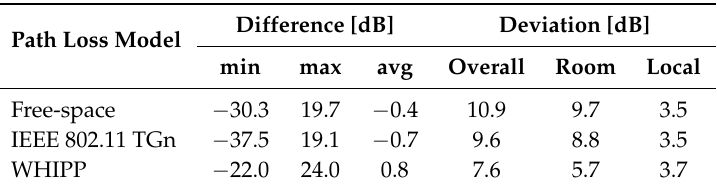
Table 1. Experimentally measured differences and deviations compared to the theoretical path loss models after